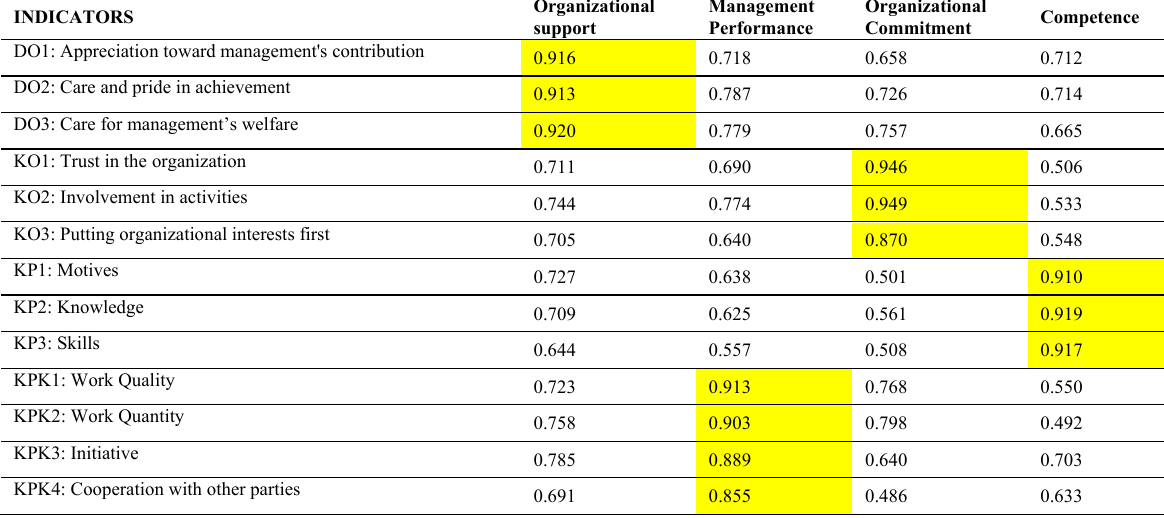
Discriminant Validity INDICATORS